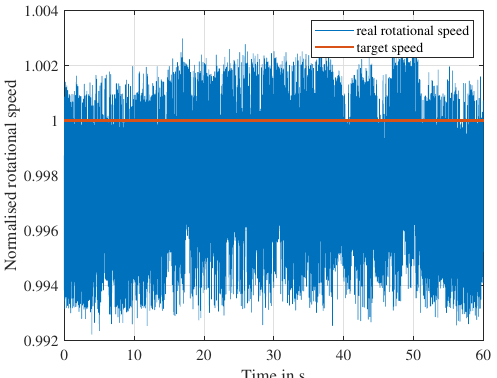
Figure 4. Variation of normalised rotational speed over an exemplary measurement. The rotational speed varies within a range of less than